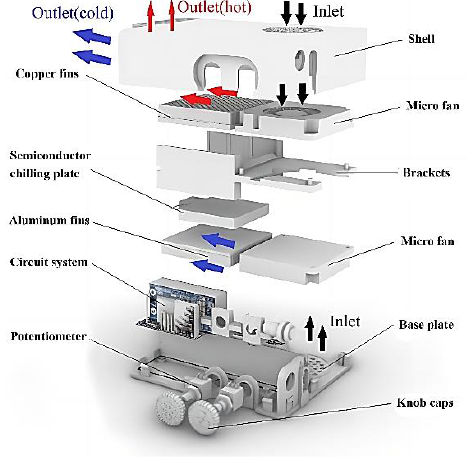
Figure 8. Exploded view of the portable refrigeration device.